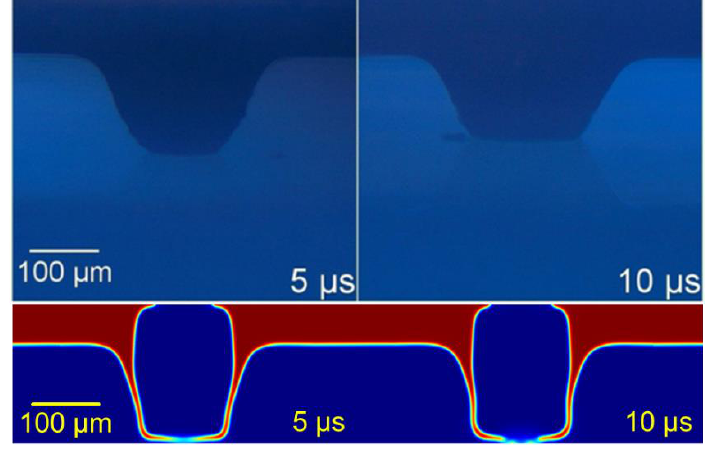
Figure 8. Stabilized column regime. Upper row adapted from [13], with PV17F paste. Lower row: simulation at 450 MPa at its maximum, for 60 μm of 2 Pa·s paste and a 140 μm gap.